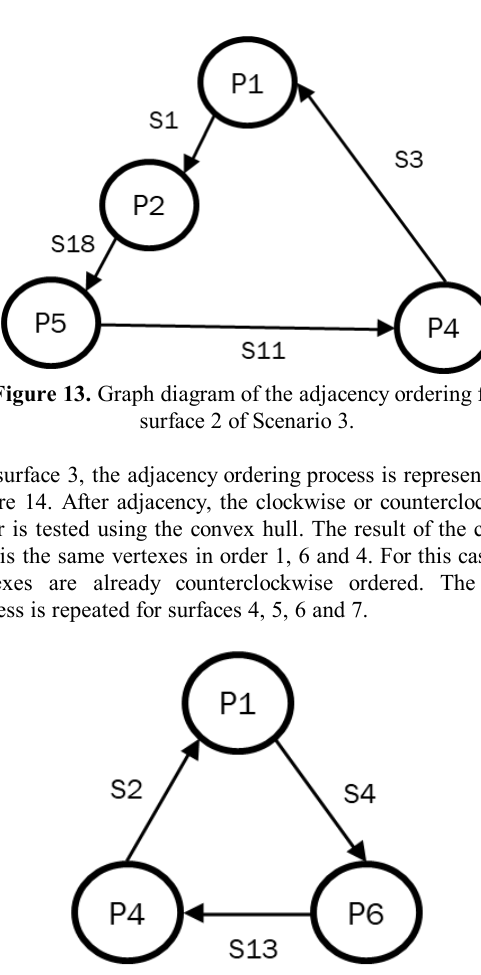
Figure 14. Graph diagram of the adjacency ordering for surface 3 of Scenario 3.